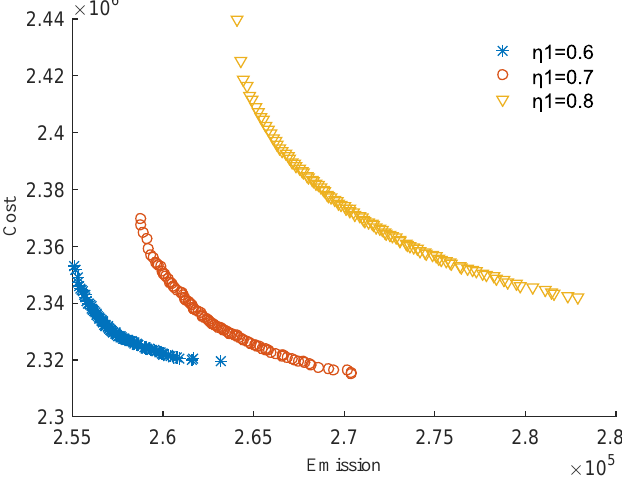
Figure 15. PFs obtained by different confidence levels η 1 . Table 6. Compromise dispatch schemes obtained by different confidence levels of η 1